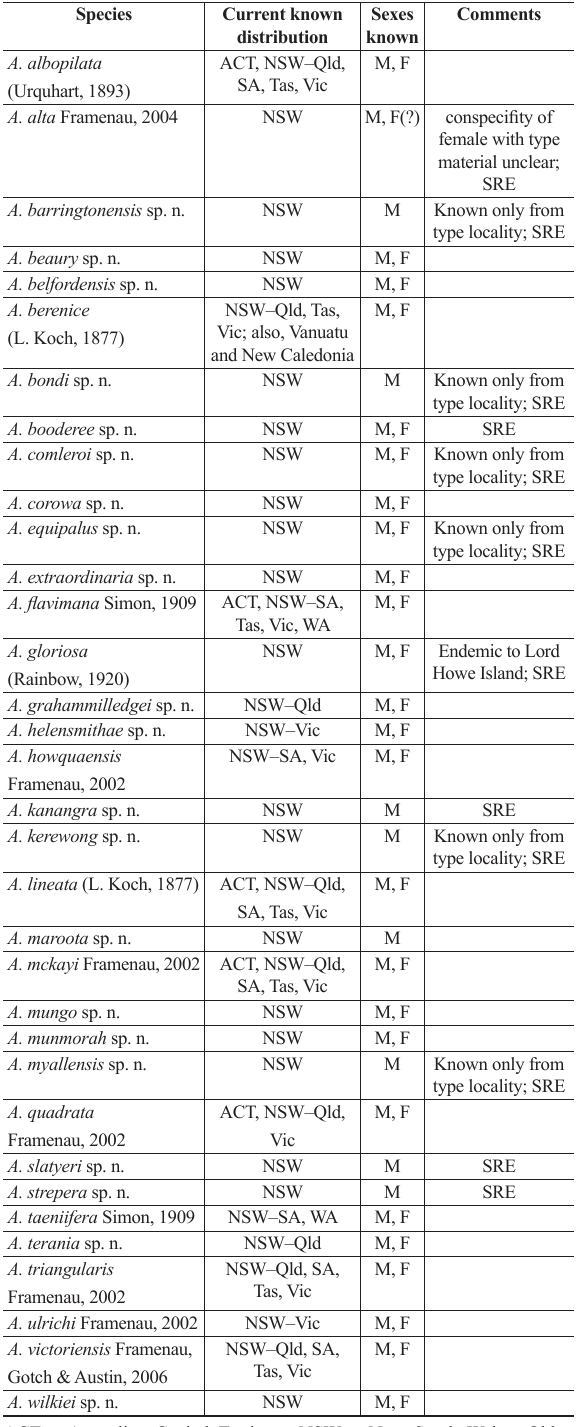
Table 1. Distribution of Artoria species currently known from New South Wales and Australian Capital